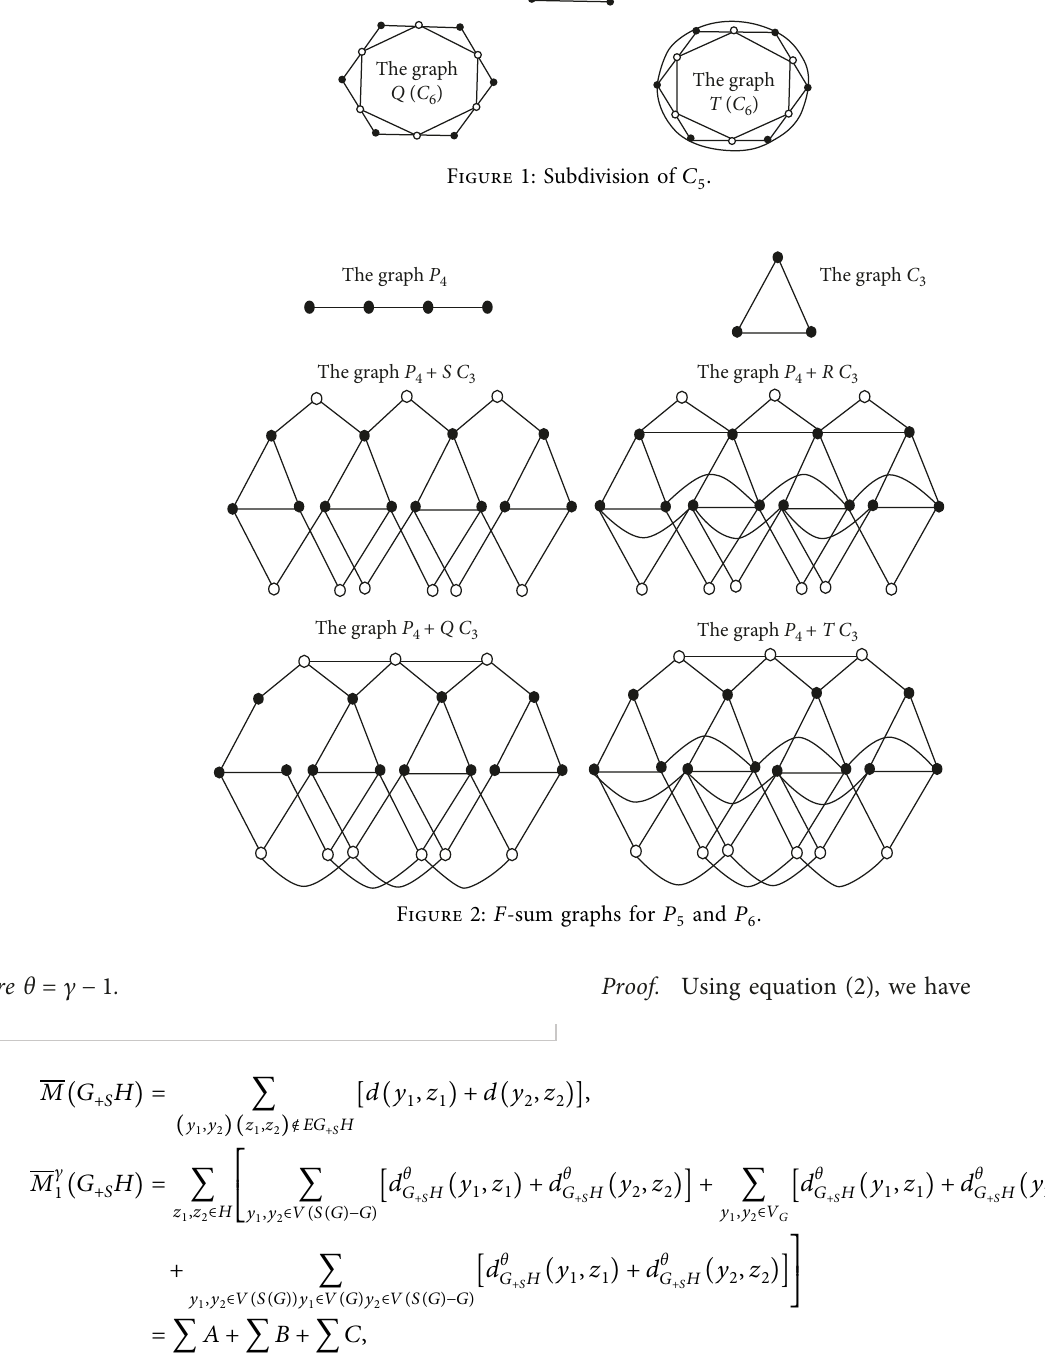
Figure 1: Subdivision of C